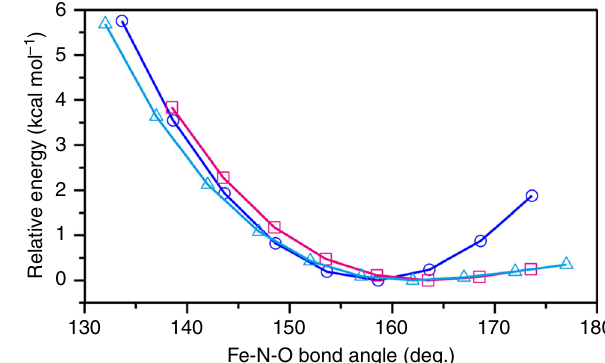
Fig. 7 Potential energy surfaces for Fe-N-O bending. The surfaces of the QM/MM, reduced QM/MM, and isolated heme QM models are shown by blue circles, magenta squares, and cyan triangles,